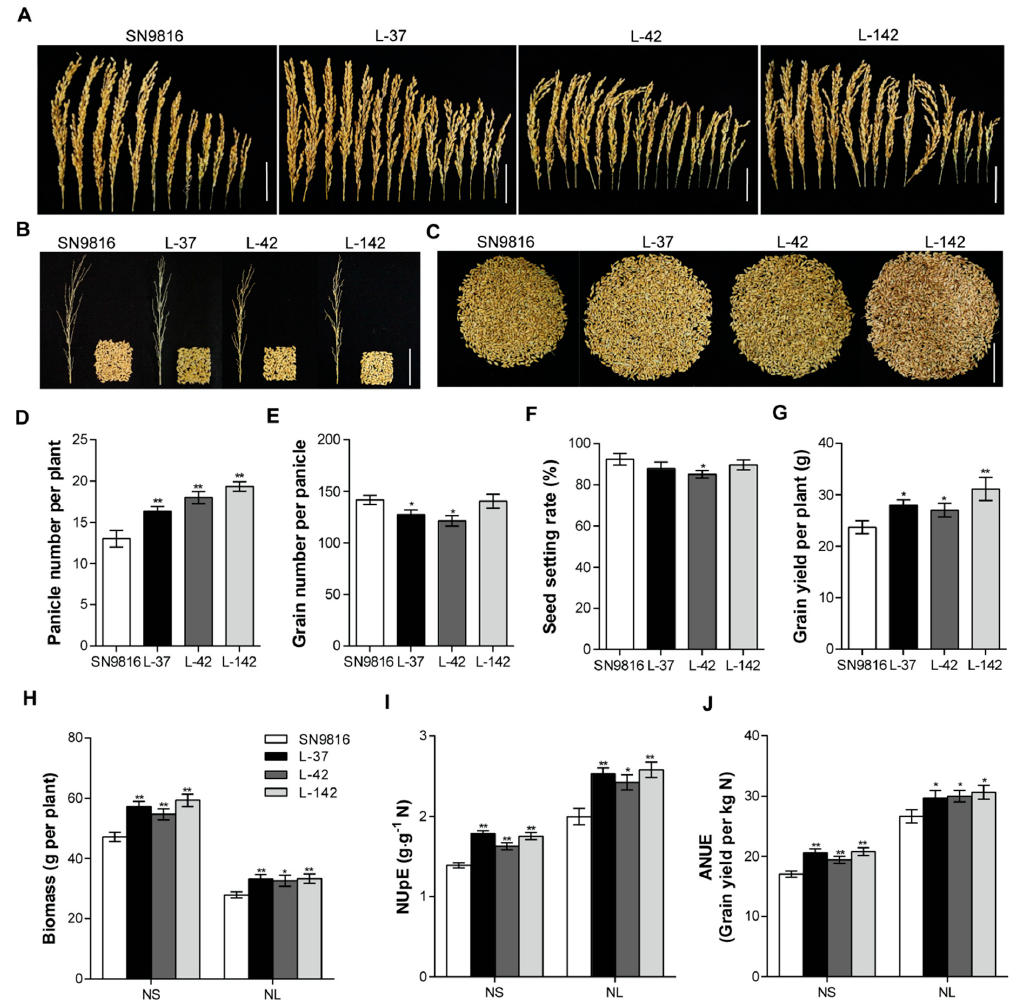
Figure 5. ( A ) The panicles per plant, ( B ) grains per panicle, ( C ) total grains per plant, ( D ) panicle number per plant, ( E ) grain number per panicle, ( F ) seed setting rate, and ( G ) grain yield per plant of SN9816 and OsATG8c -overexpressing transgenic rice grown under NS (225 kg·ha − 1 ) conditions. Scale bar: 5 cm. Biomass per plant (dry weight of all aboveground) ( H ), nitrogen uptake efficiency (NUpE) ( I ), and nitrogen use efficiency (NUE) ( J ) of SN9816 and OsATG8c -overexpressing lines grown under NS (225 kg·ha − 1 ) and NL (75 kg·ha − 1 ) conditions. Values are the means ± SD ( n = 12), * p < 0.05, ** p < 0.01 (t-test).